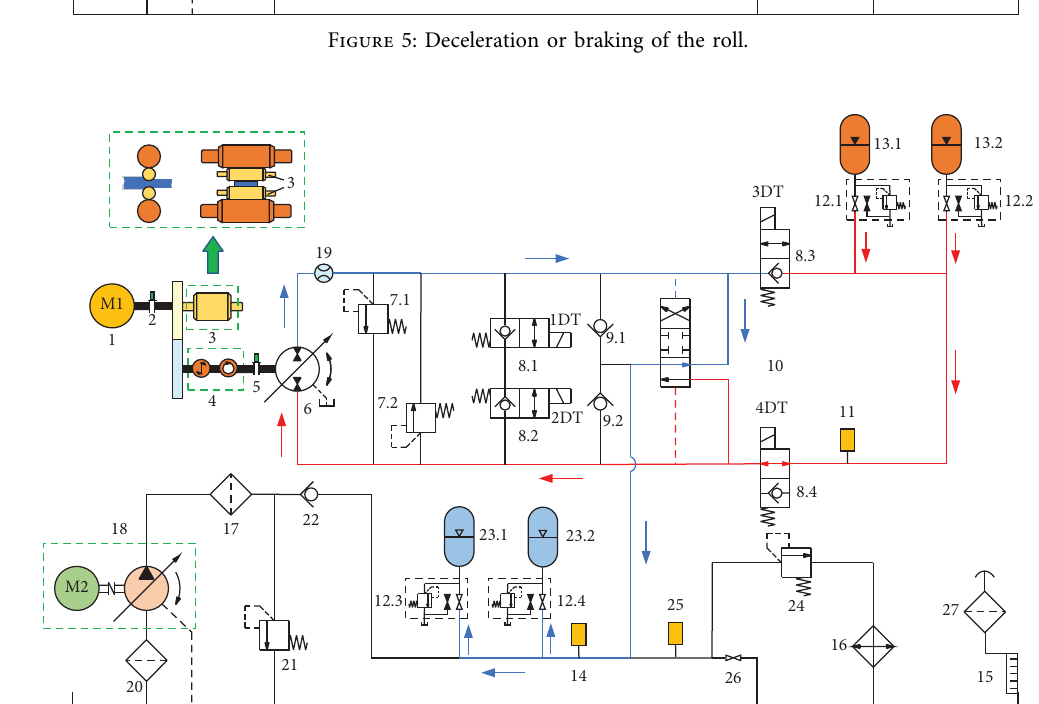
Figure 6: Acceleration or starting of the roll.